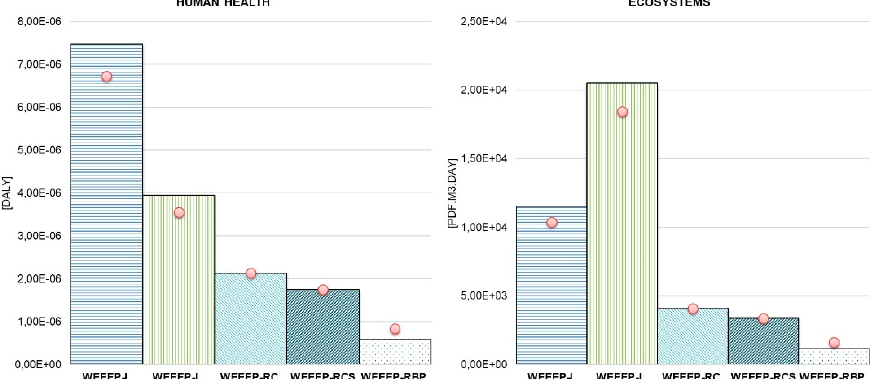
Figure 7. Environmental impacts associated with the five end-of-life scenarios (WEEEP-I, WEEEP-L, WEEEP-RD, WEEEP-RCS, and WEEEP-RBP) for 1 kg of e-plastic treatment residues including the influence of the sensitivity options (S1). Shown are the USEtox end-point results for the damage categories “human health” and “ecosystems”.